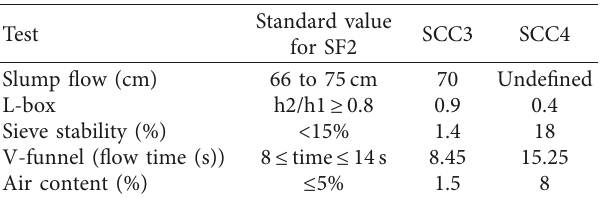
Table 11: Properties of the two concretes SCC3 and SCC4 in fresh